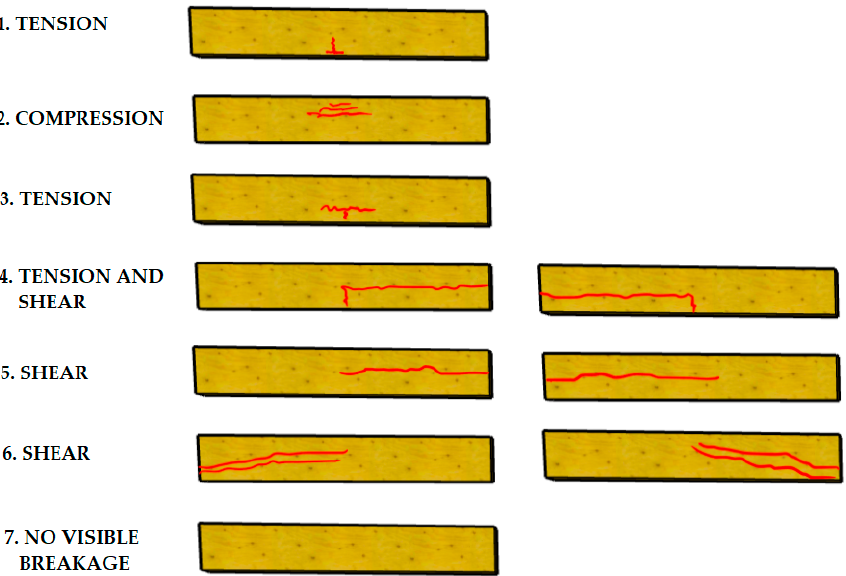
Figure 4. Classification of failure modes in the timber beams subjected to bending according to [56].